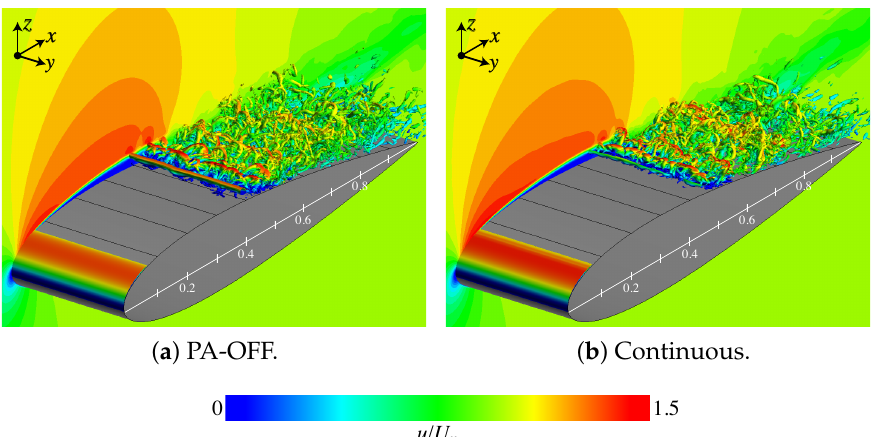
Figure 13. Instantaneous flows with the isosurface of the second invariant of the velocity gradient tensor colored with the chordwise velocity ( u / U ∞ ) at α = 6.